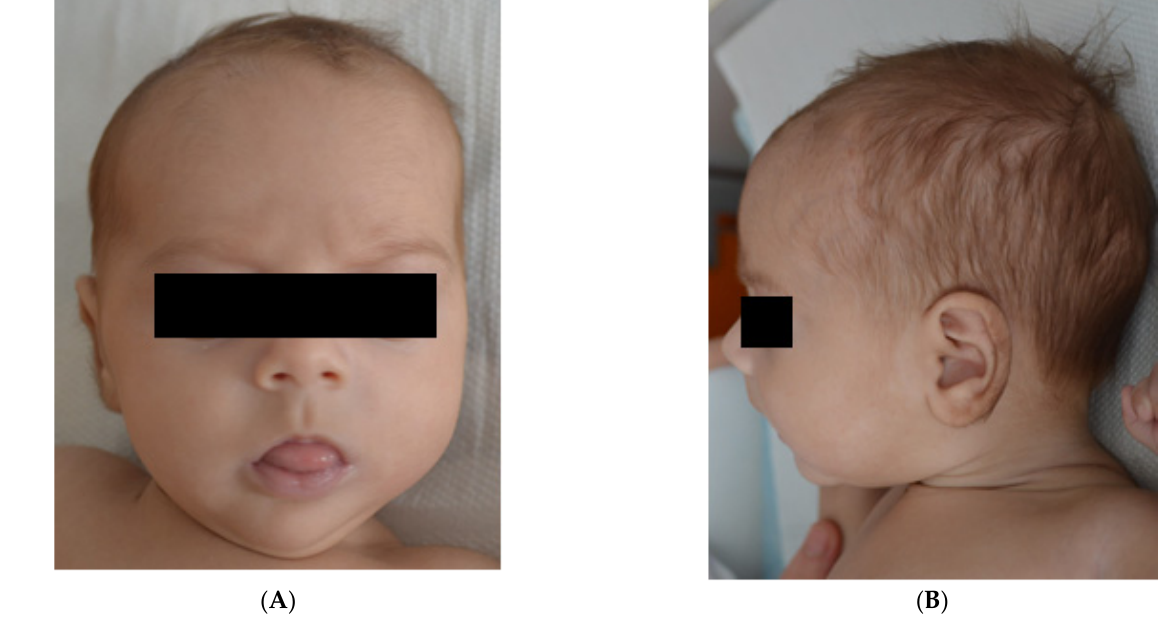
Figure 1. ( A ). Frontal bossing, downslanting palpebral fissures. ( B ).